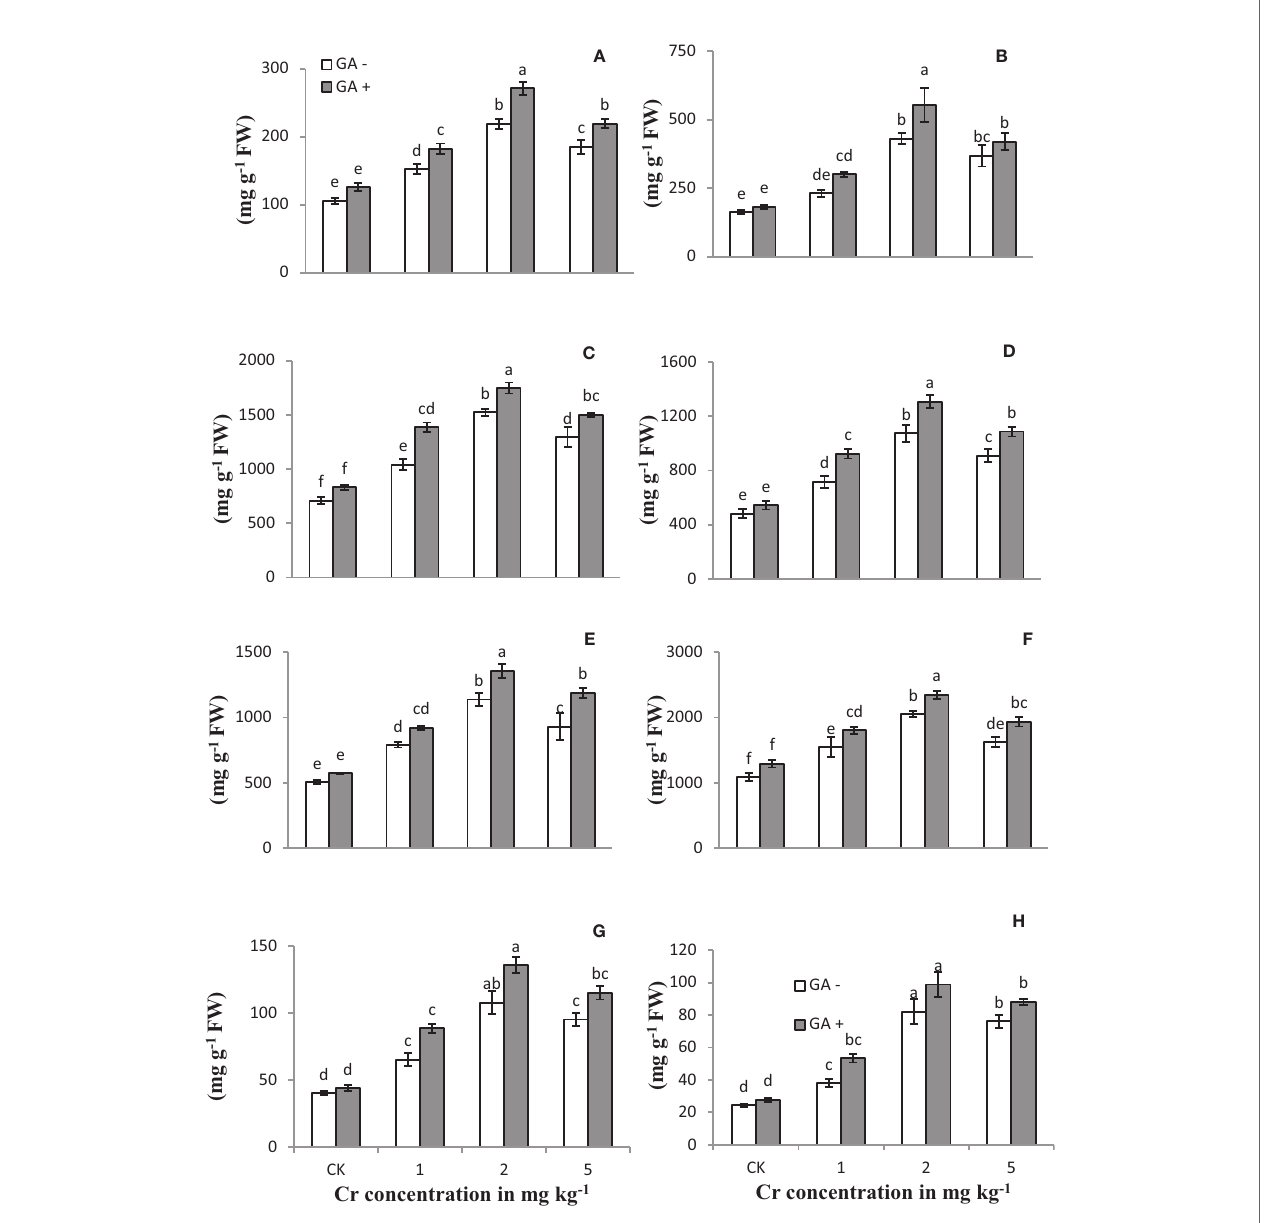
FIGURE 4 | Effect of Cr and GA on APX in root (A) , APX in leaves (B) , CAT in root (C) , CAT in leaves (D) , POD in root (E) , POD in leaves (F) , SOD in root (G) and SOD in leaves (H) of Sun fl ower grown in soil with increasing Cr concentrations (0, 1, 2 and 5 mg kg − 1 ) and GA (0 and 5 mM). Values are demonstrated as means of fi ve replicates along with standard deviation. Different small letters indicate that values are signi fi cantly different at P < 0.05